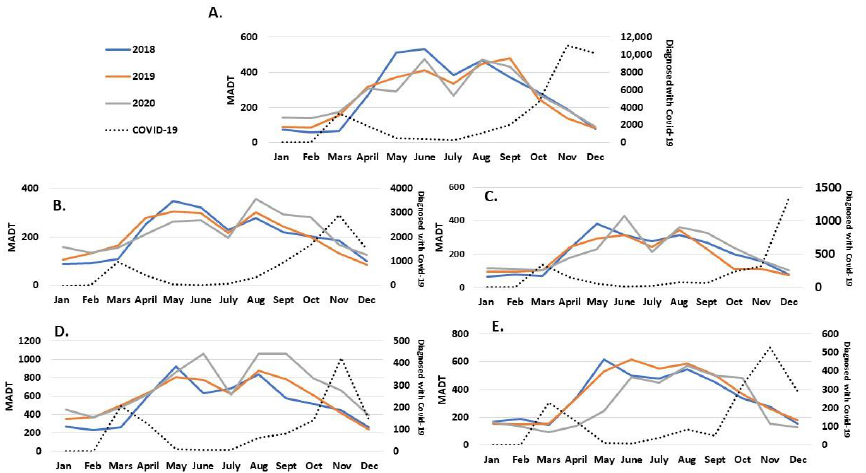
Figure 3. Regional monthly average daily traffic from 2018 to 2020 highlighting the monthly number of individuals diagnosed with COVID-19 (2020). ( A ) Eastern Norway, ( B ) Western Norway, ( C ) Mid Norway, ( D ) Sothern Norway, ( E ) Northern Norway. MADT stands for monthly average daily traf- fic.